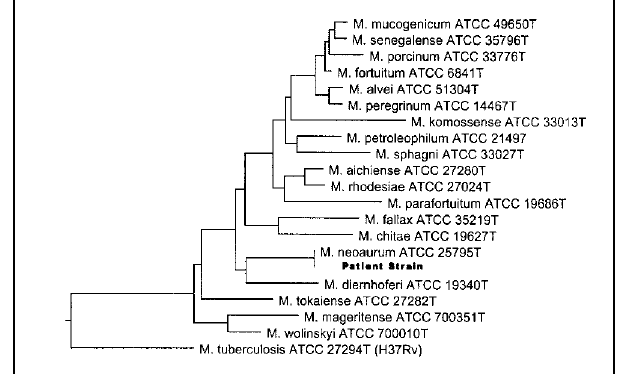
Figure 2) Phylogenetic tree based on the 5' region of the 16S rRNA gene ( Escherichia coli bp 54-510) of the patient strain and its closest relatives. Sequences of all reference strains were determined at the National Reference Centre for Mycobacteriology, Health Canada. This tree was constructed using the Clustal method algorithm in the Megalign component of the Lasergene program version 4.01 (DNAS- TAR, Inc, USA). The tree was rooted using Mycobacterium tuber- culosis , a slow-grower, as the out-group sequence. T Type